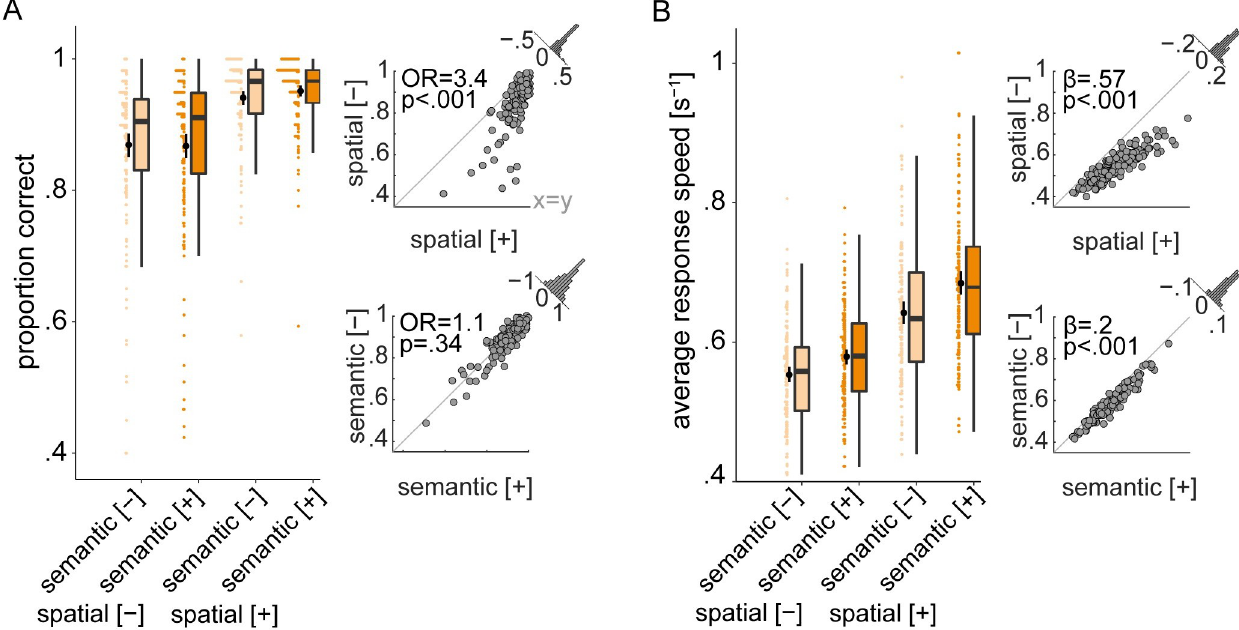
Fig 2. Individual behavioral benefit from informative listening cues. (A) Proportion of correct final word identifications averaged over trials per cue condition (B) The same as (A) but for average response speed. Box plots: Colored data points represent trial-averaged performance scores of N = 154 individuals per cue–cue combination. Black bars show mean ± bootstrapped 95% CI. Scatter plots: Individual cue benefits shown separately for each cue and performance score. Black data points represent individuals’ trial-averaged scores under informative [+] and uninformative [ − ] cue conditions. Gray diagonal corresponds to 45-degree line. Histograms show the distribution of the cue benefit (informative minus uninformative) across all participants. OR: odds ratio parameter estimate resulting from generalized linear mixed-effects models; β : slope parameter estimate resulting from general linear mixed-effects models. The data underlying this figure can be found at https://osf.io/ge2cq/.